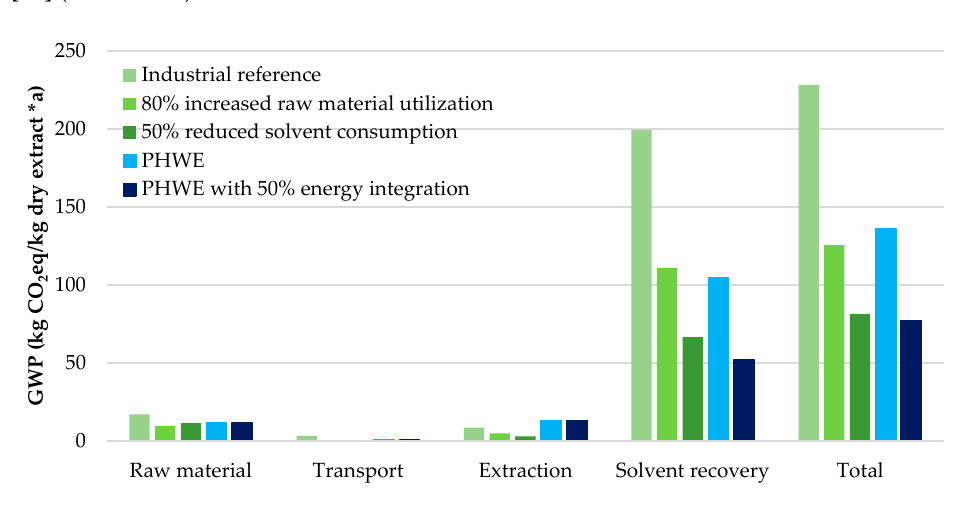
Figure 12. Comparison of different optimization approaches on total global warming potential (GWP) of the process. Pressurized hot water extraction (PHWE). Table 4. Optimization pathways for solid–liquid extraction. Pressurized hot water extraction (PHWE).